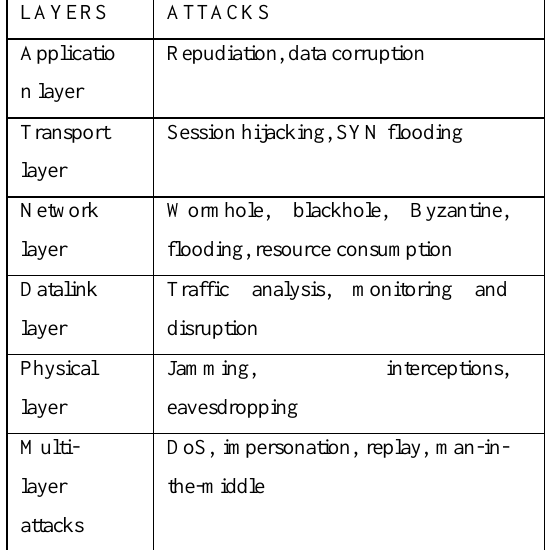
Figure. 2 TCP three-way handshake